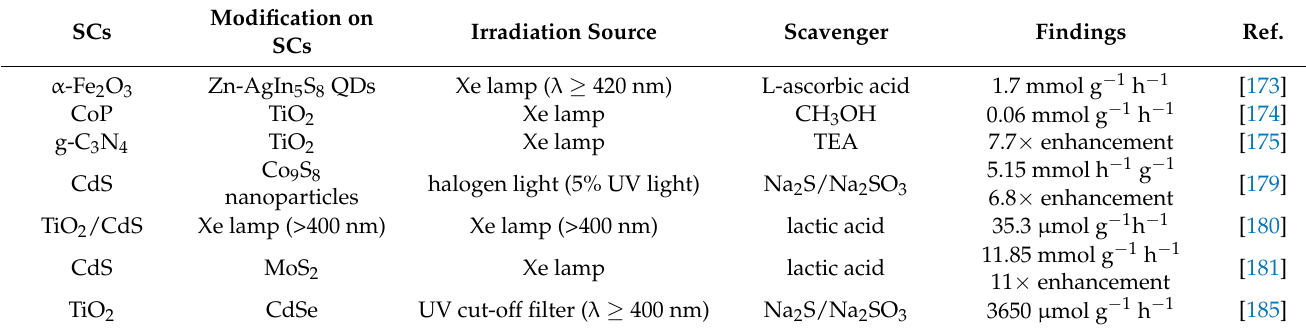
Table 5. Examples of multi-dimensional photocatalysts applied for photocatalytic hydrogen